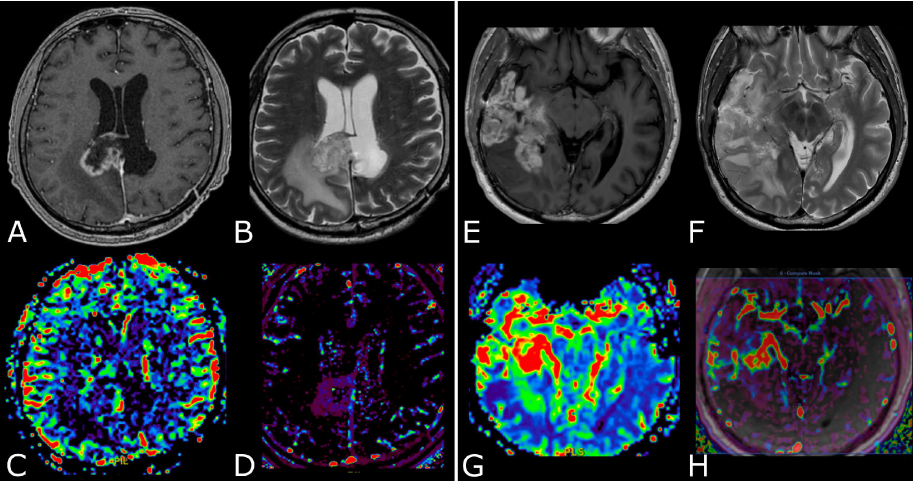
Figure 5. Post-treatment changes vs. disease progression. ( A – H ): axial 3D-FSPGR post-contrast T1w images ( A , E ) and T2w images ( B , F ) with corresponding DSC-CBV ( C , D ) and DCE-Ktrans perfusion maps ( G , H ) of two IDHwt GBs 1 year after treatment (surgery and radio-chemotherapy). In the left panel the enhancing tissue shows low DSC-CBV and DCE-Ktrans, consistent with post-treatment changes. In right panel the enhancing tissue shows areas of increased DSC-CBV and DCE-Ktrans, suggesting disease